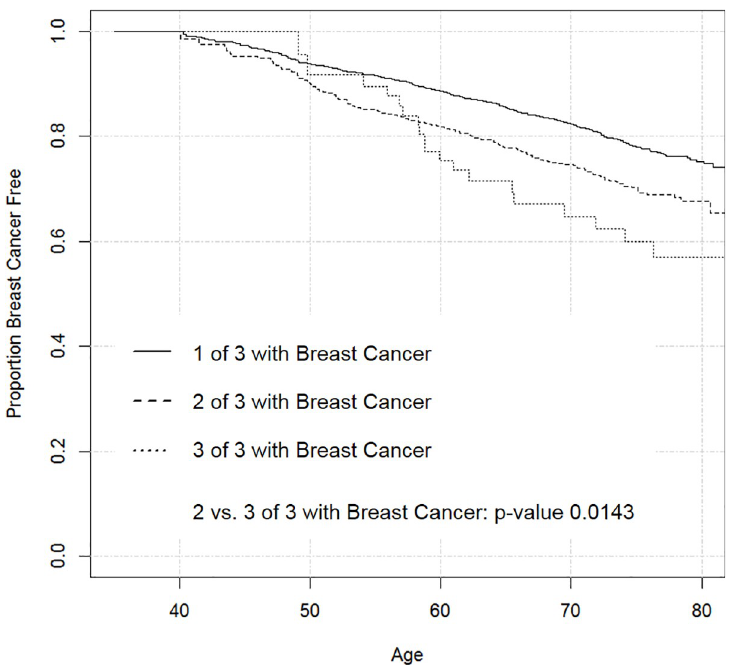
Fig 1. Kaplan-Meier curves of proportion breast-cancer-free for Sister Study participants with three first-degree female relatives, stratified by number of first-degree female relatives with breast cancer.